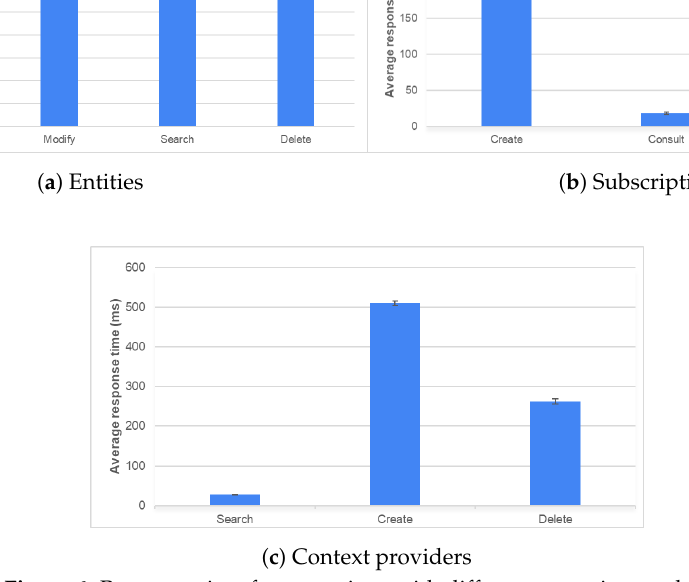
Figure 6. Response time for operations with different operating methods. Table 2. Average response times (ms) for each type of operation and